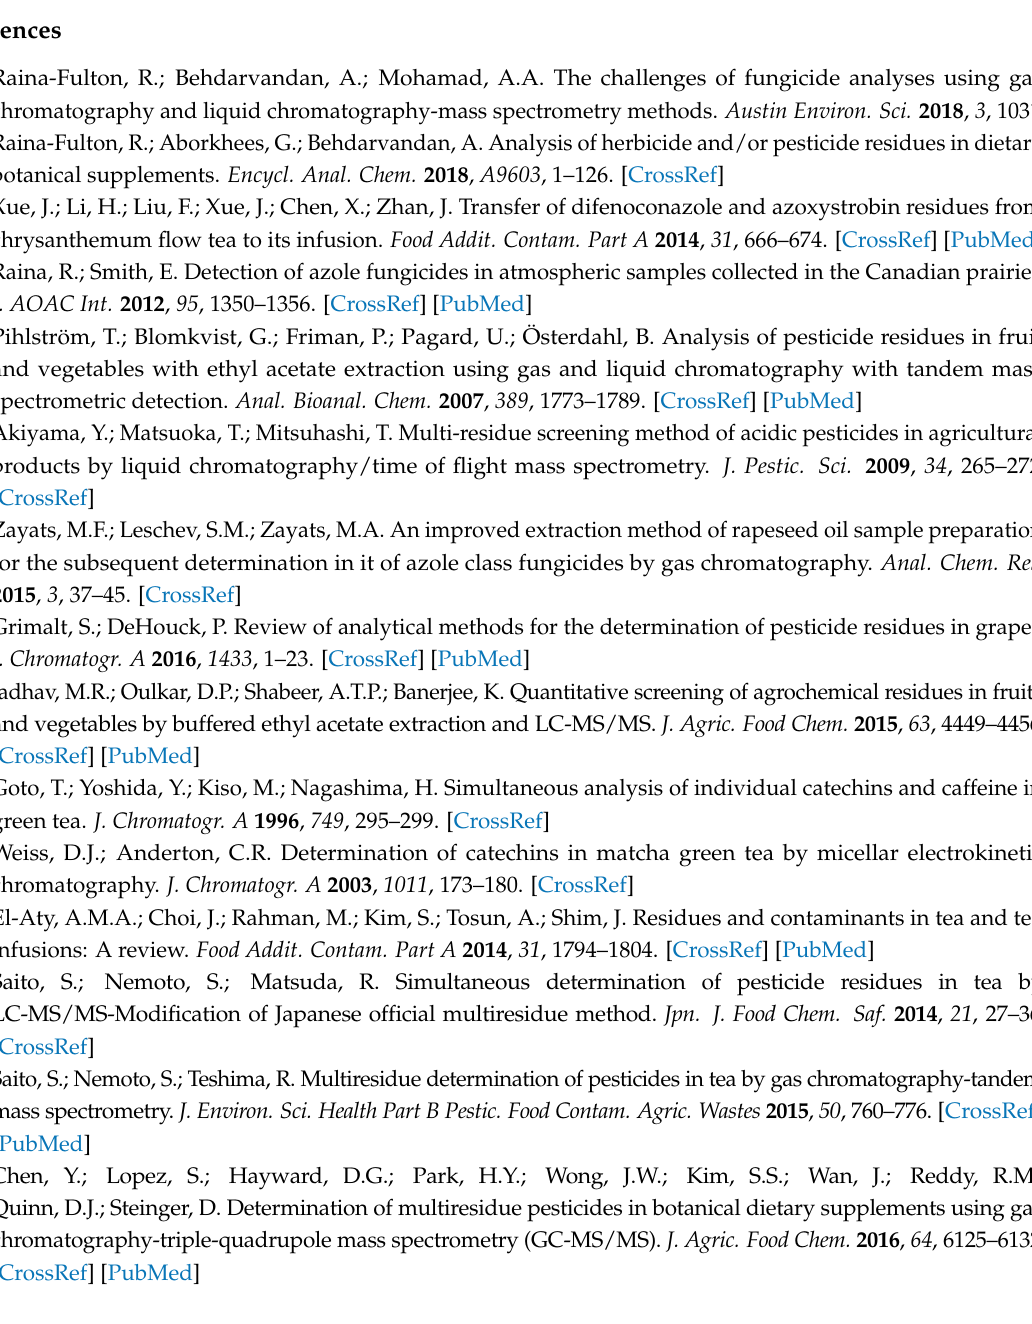
Figure S1: Selected Reaction Monitoring Chromatograms of Diniconazole With and Without Matrix Added, Table S1: Method Detection Limit, Regression Coefficient of Matrix Matched Calibration Curve, and Percentage Matrix Effects for Target Analytes Analyzed by LC-ESI +